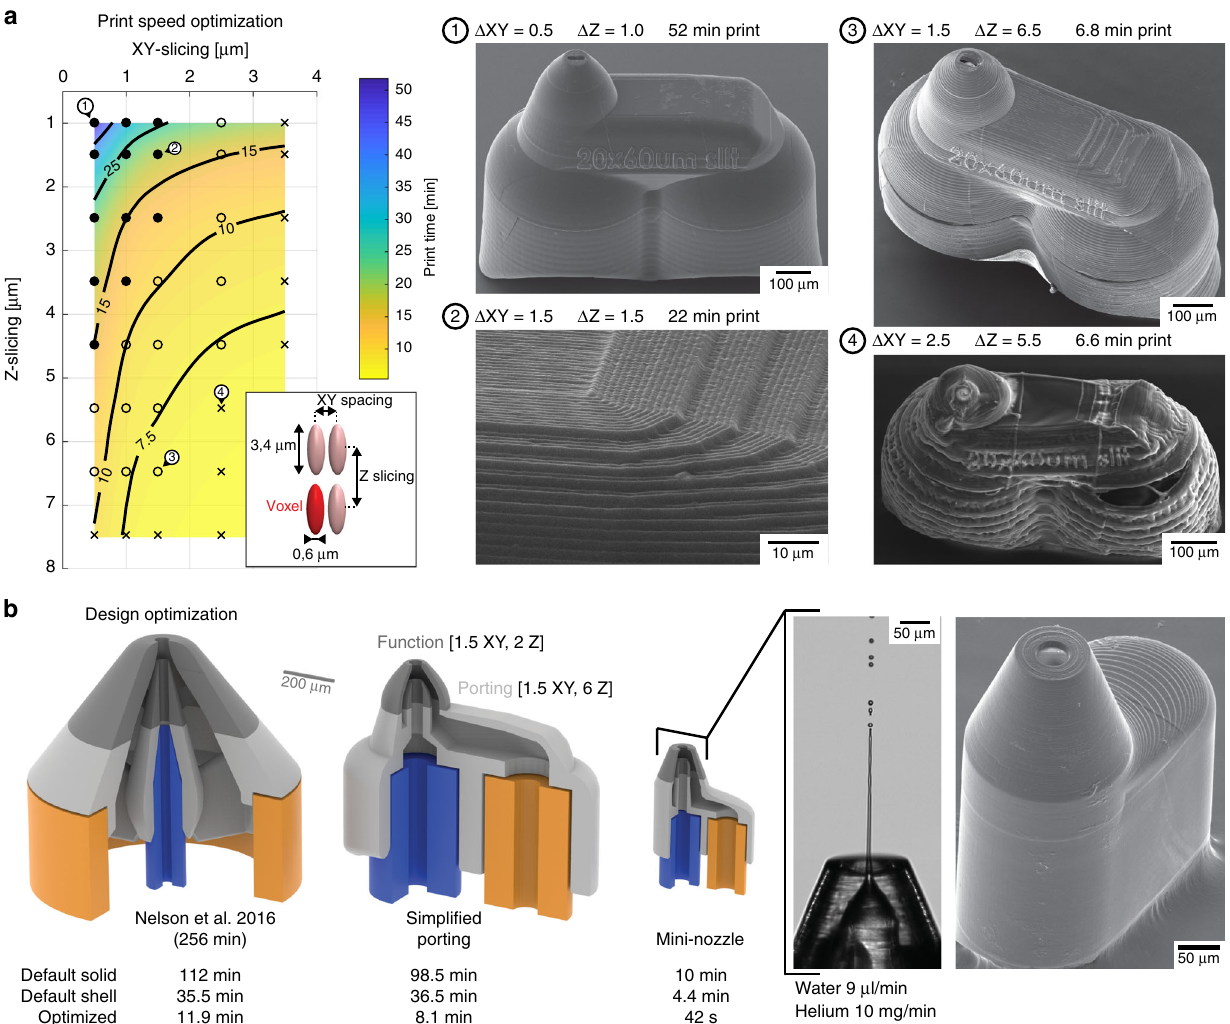
Fig. 2 Optimizing 2-photon stereolithography for ef fi cient fabrication. a To increase print speed, vertical (Z) and horizontal (XY) slicing parameters were screened to optimally use the available voxel exposure volume of the reference nozzle (simpli fi ed porting design). Narrow XY and Z spacings print slowly, but yield clean surfaces for critical micro fl uidic elements (point). Increased voxel spacing results in more rugged surfaces, but print faster and are ideal for non-critical elements such as structural supports or inlet ports (open circle). Too large voxel spacings are prone to structural failure during processing (cross). b Print time reduction by device and interface miniaturization. Nelson et al. 3 pioneered a 3D-printed nozzle by directly adapting a manually fabricated all-glass GDVN, even preserving the concentric capillary arrangement. Reducing the functional part (nozzle tip) and a simpli fi ed capillary porting improved print speed, as well as fi nal assembly yields. Stringent reduction of unnecessary printed volume allowed for further device miniaturization and an overall print speed reduction to less than a minute per nozzle (Supplementary Movie 1). Gray color corresponds to the 3D-printed nozzle body, while blue and orange colors depict glass capillary lines to supply liquid and gas, image-based jet diameter measurements with visible light, which (Supplementary Fig. 5), con fi rming the self-consistency of our in practice become unreliable for diameters below 2 µm 23 . While measurements. While the jet speed dependence on gas mass fl ow rate was in excellent agreement with previous theoretical environmental electron scanning microscopes can accurately resolve nanometer features 14 , their long integration times on the predictions 10 , the observed liquid fl ow rate scaling has to our order of seconds average out dynamic jet instabilities. Our dual- knowledge not been reported yet. Measured jet lengths pulse iLIF combines accurate assignment of jet velocities and increased proportionally with water fl ow rate from 50 up to operating modes, which we classify 11 as stable, metastable 225 µm (Fig. 3d), while jet diameters down to 536 ± 35 nm at (occasional fl uctuations), unstable jetting (continuous whipping), (Fig. 3e) were observed. This offers remarkable opportunities and no jet dripping regime (Fig. 3b) (Supplementary Movies 2 – 5). for low-background diffractive imaging with X-ray free-electron A detailed characterization of our 15 × 45 µm 2 slit nozzle (Fig 3a, Design 2) using a test chamber 11 evacuated to ~1 mbar laser pulses. Our GDVN Design 2 (Fig. 3a) reduced sample pressure revealed a broad region of water jetting stably at jet consumption by more than fi vefold compared to previous speeds ranging from 20 m s − 1 to about 180 m s − 1 at the highest manually assembled GDVNs, which required water fl ow rates in stable gas fl ow and lowest liquid fl ow (Fig. 3c). We found the range of 10 – 20 μ l min − 1 (refs. 11,23 ). This nozzle was successfully used in the laboratory under test conditions for SFX all measured jet speeds, v j , to scale with gas mass fl ow rate, (cid:3) 1 = 3 experiments and actual SFX experiments, for the delivery of (cid:2) m 1 = 2 Q m gas , and liquid fl ow rate, Q liq , according to v jet gas liq